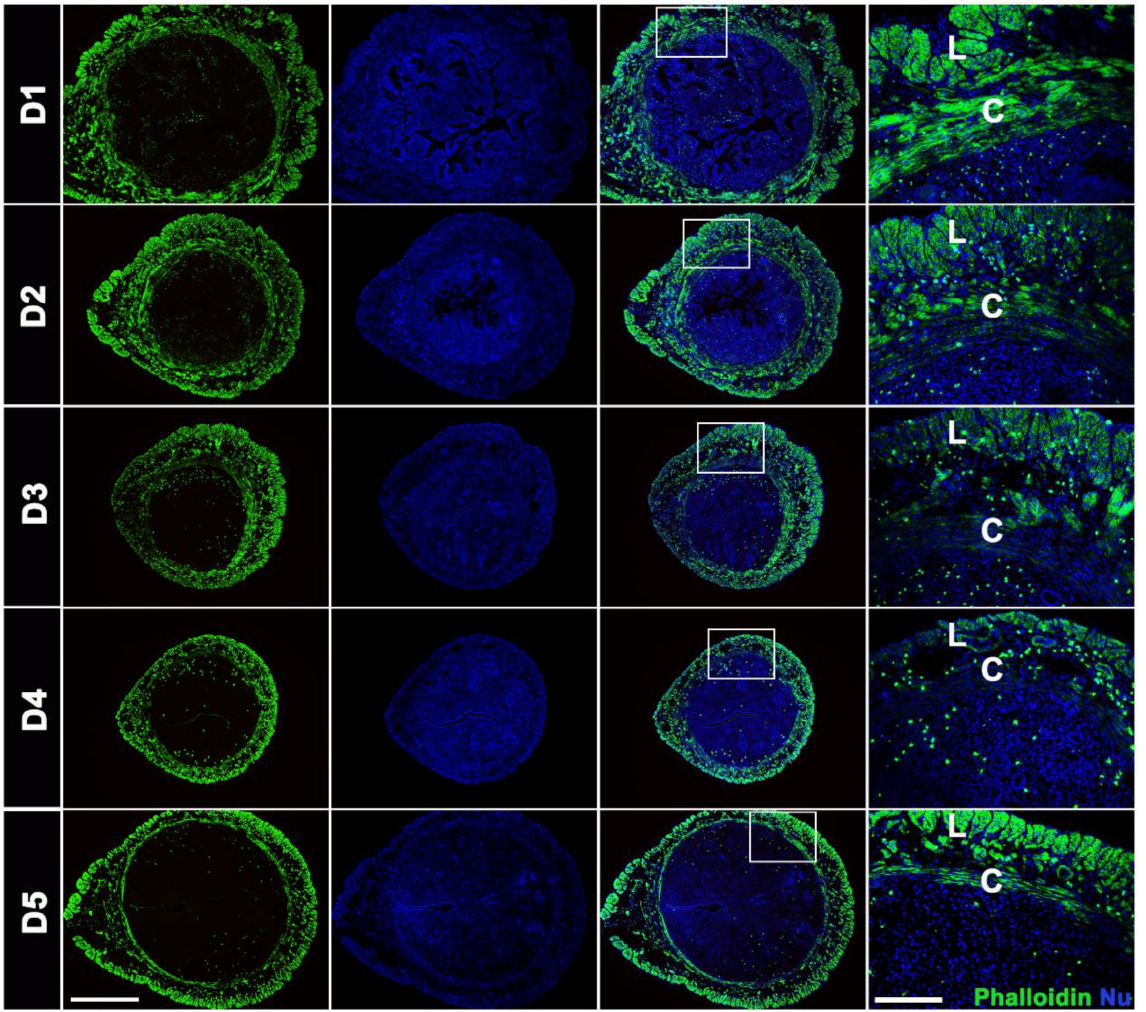
Figure 1. Phalloidin staining in mice uterus of early pregnancy. Phalloidin staining in mice my- ometrium on days 1 to 5 of pregnancy, Phalloidin (green), the nuclei were counterstained using DAPI (blue). L, longitudinal muscle layer; C, circular muscle layer. Scale bars = 200 µ m, 500 µ